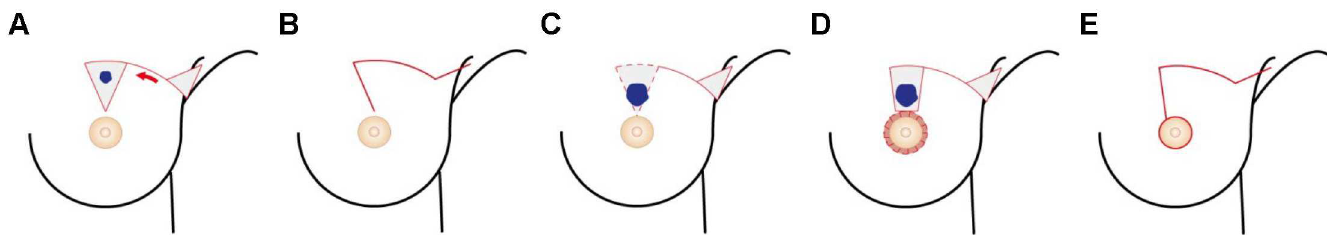
Fig 3. Surgical technique of the matrix rotation. The non-donutmethod was employedfor those tumors which could be resected by a reverse-triangular shaped en bloc resectionwith negative margins(A). A concave incision was made along the lateral border of the breast from the tumor site to the midaxillary line, followedby a small triangular-shaped incisionin the axilla to facilitate lymph node management and subsequently flap advancement (B). For tumors locatedless than 3 cm away from NAC or if safety marginscould not be obtained by non-donut en bloc resection (C), the donut method was used which involvedperiareolar de-epithelialization and en bloc resectionin a rectangularshape (D and E).